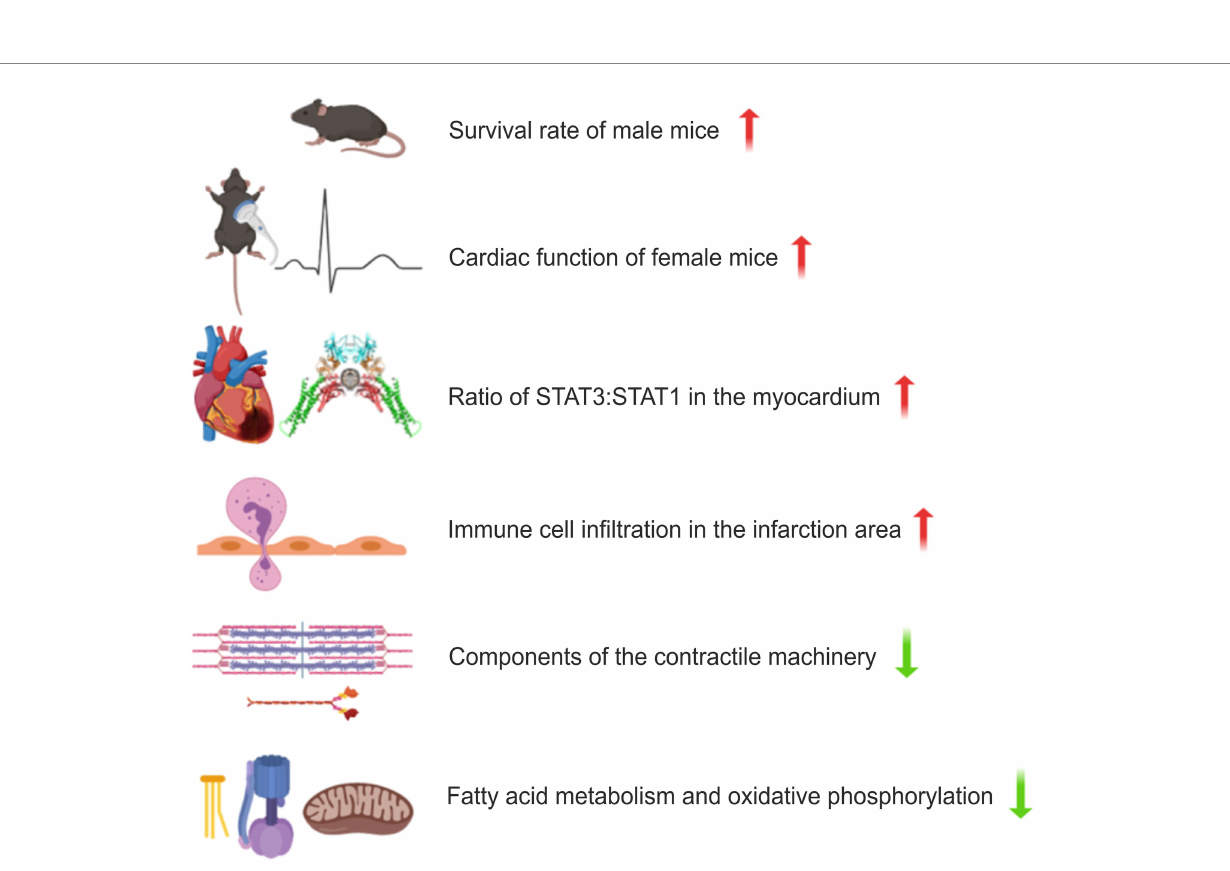
FIGURE 6 Schematic presentation of the effects of disrupted co-operative DNA binding in a murine model of myocardial infarction (MI). Male mice with a homozygous F77A mutation show a higher survival rate following left anterior descending artery (LAD) ligation, while the haemodynamic function of the ischaemic heart is less affected in female mice. Changes in the STAT protein levels as well as differentially regulated KEGG cellular processes are depicted for female STAT1 F77A/F77A mice. Upregulated pathways are displayed in red and downregulated pathways are in green. In the comparison between the transcriptomes from ischaemic and non-ischaemic myocardial tissues, prominent genotype-specific differences were observed for cardiac muscle contraction, fatty acid metabolism and oxidative